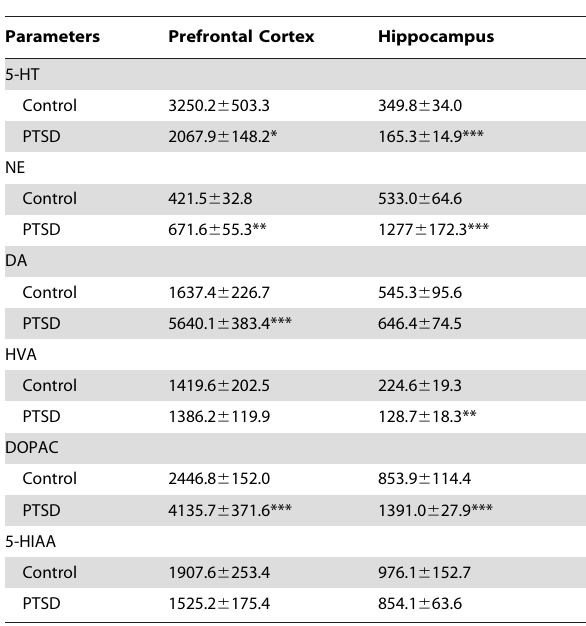
Table 1. Changes in the levels of biogenic amines and metabolites in the PFC and hippocampus after the 31-day predator exposure/psychosocial stress